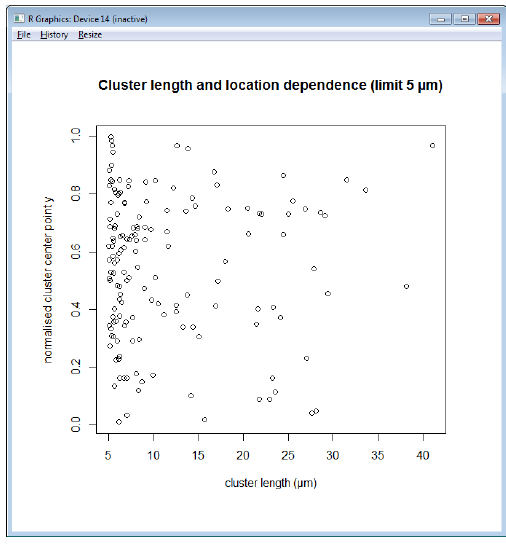
Figure 9: Distribution of clusters in terms of length and